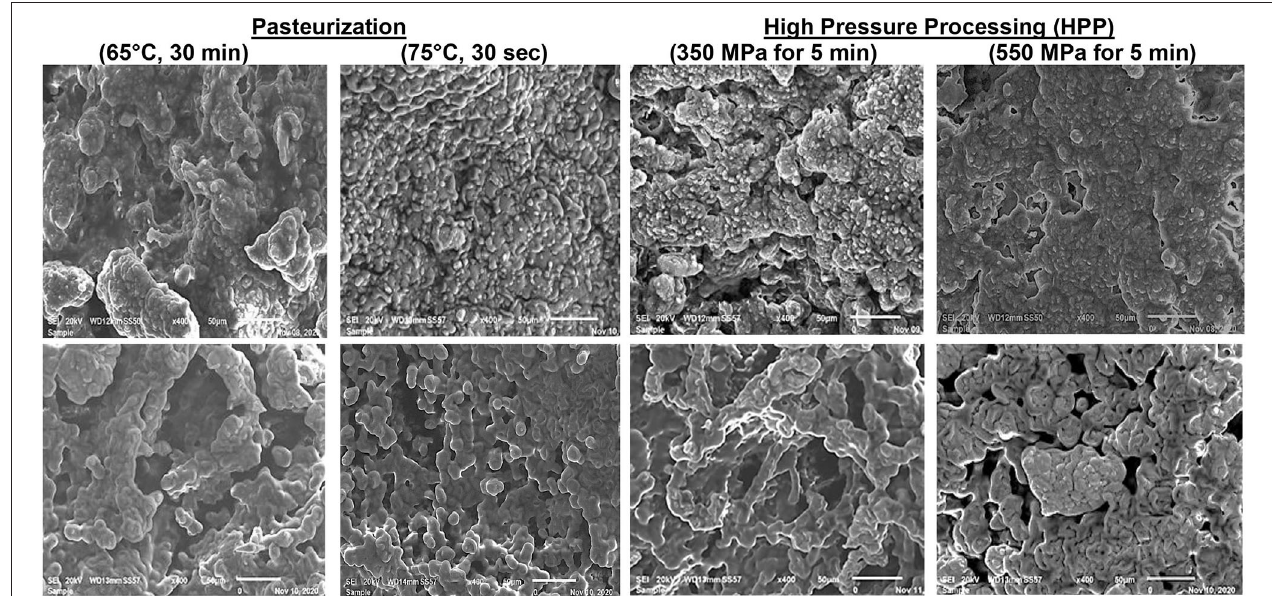
FIGURE 2 | Scanning electron micrograph of camel cheeses (Upper panel) and bovine cheeses (Lower panel) with two pasteurization temperatures and two high-pressure treatments applied to the milk (Magnification: × 400).